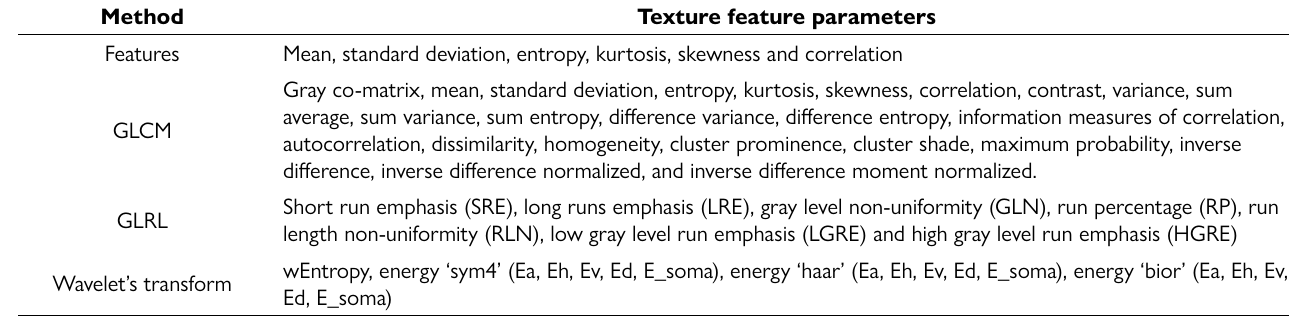
Table 2. Gray level co-occurrence matrix (GLCM), gray level run-length (GLRL) and Wavelet’s transform features.